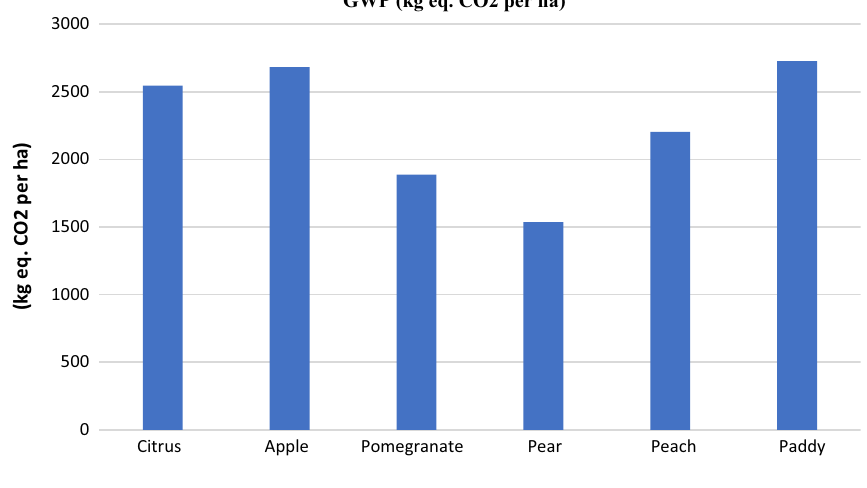
Fig. 3 Greenhouse gas emission rates of horticultural crops and paddy crop in Tajan